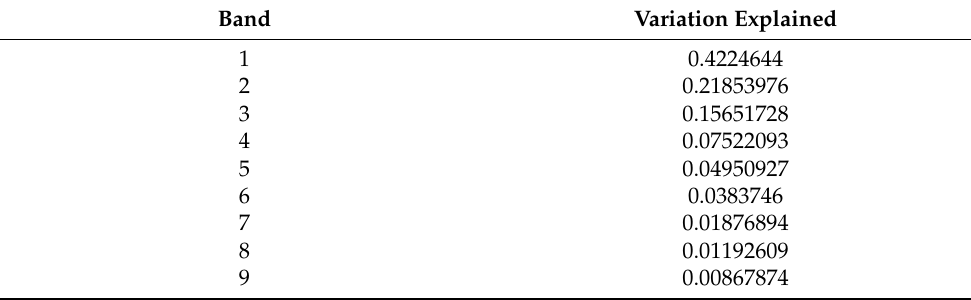
Table A21. TLS PCA band variation explained at 5m grid